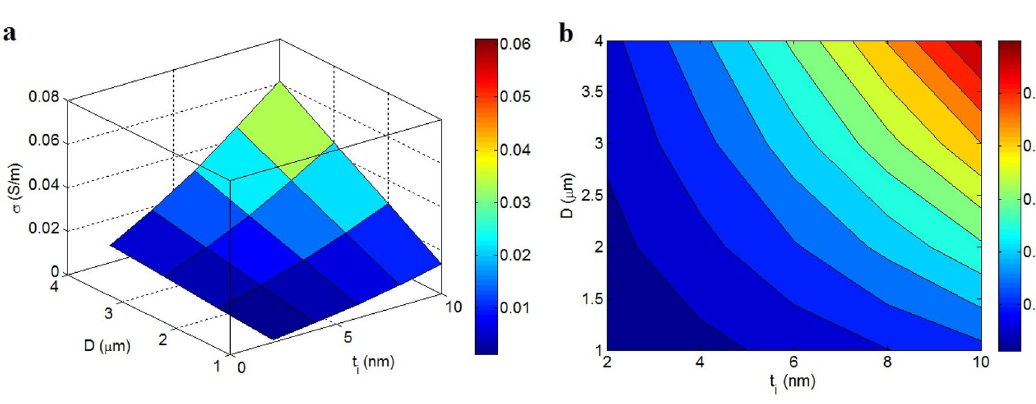
Figure 5. Conductivity of nanocomposites by “t i ” and “D”: ( a ) 3D and ( b ) contour